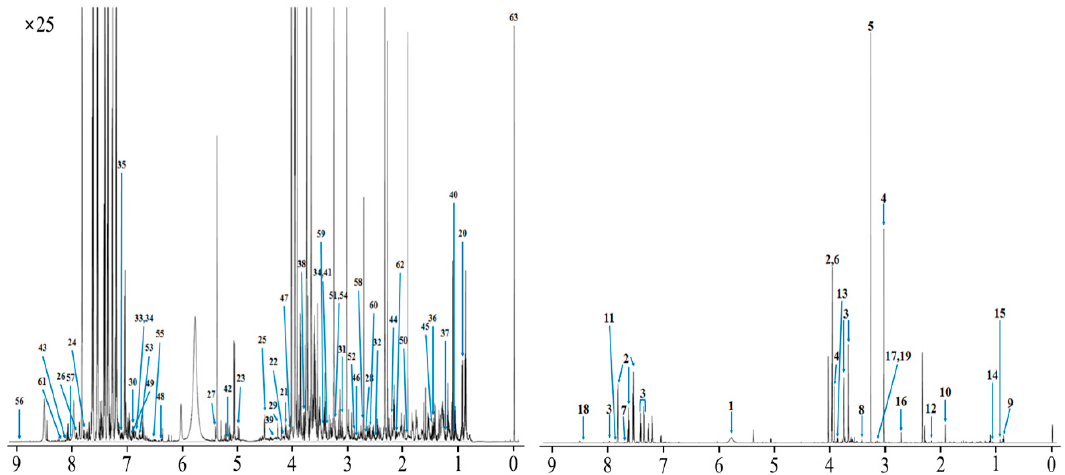
Figure 3. The representative spectrum 1 H-NMR spectroscopy obtained from Hanwoo steers urine.